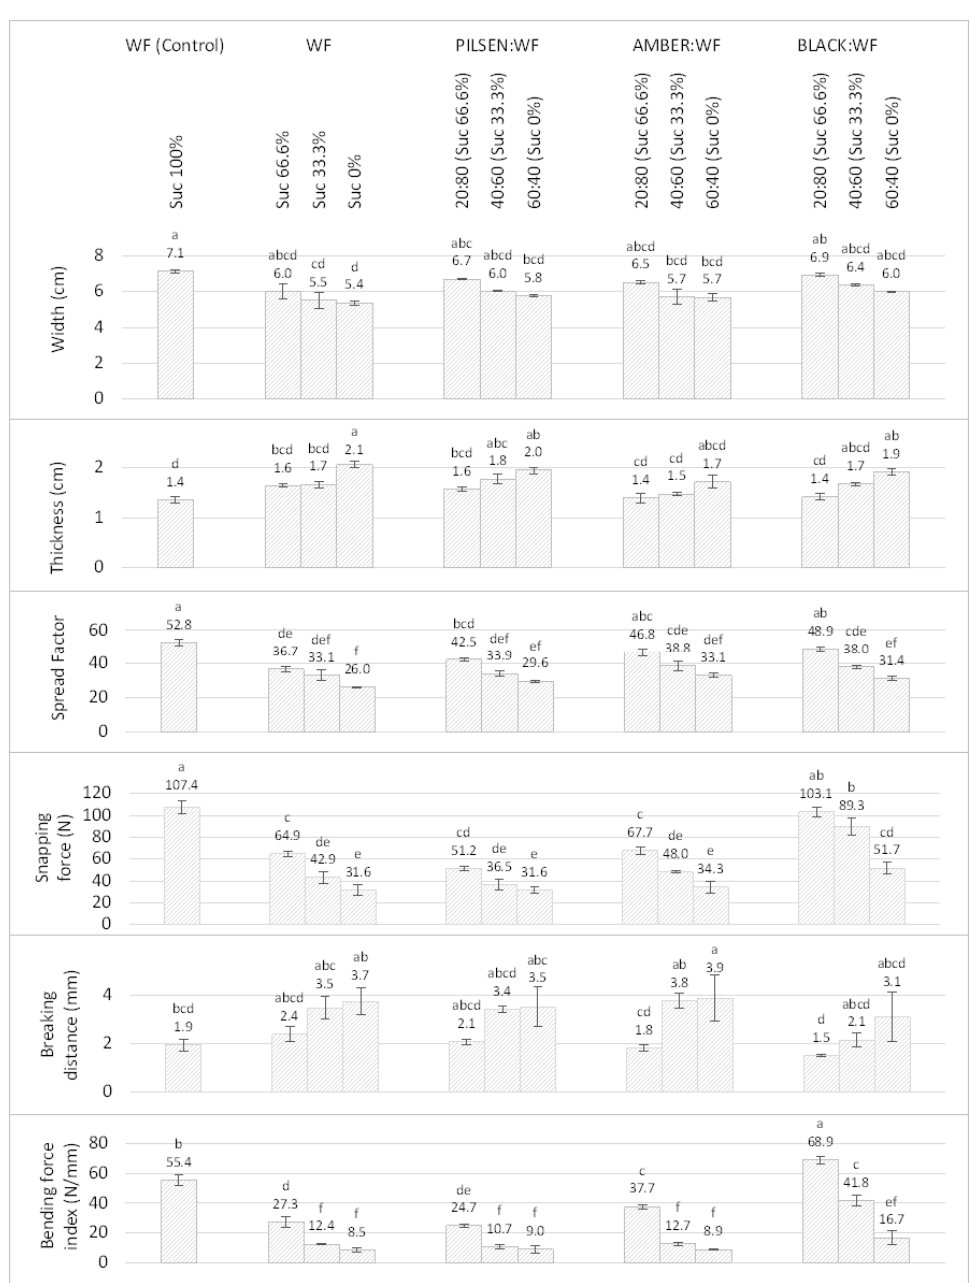
Figure 3. Dimensional and textural properties of cookies made from malted barley and wheat composite flours with reduced sucrose addition. WF—Wheat flour. Suc%: Percentage of added sucrose compared to standard recipe. The values are Mean ± SD ( n = 6). Different letters (a–f) indicate statistically significant differences ( p < 0.05).